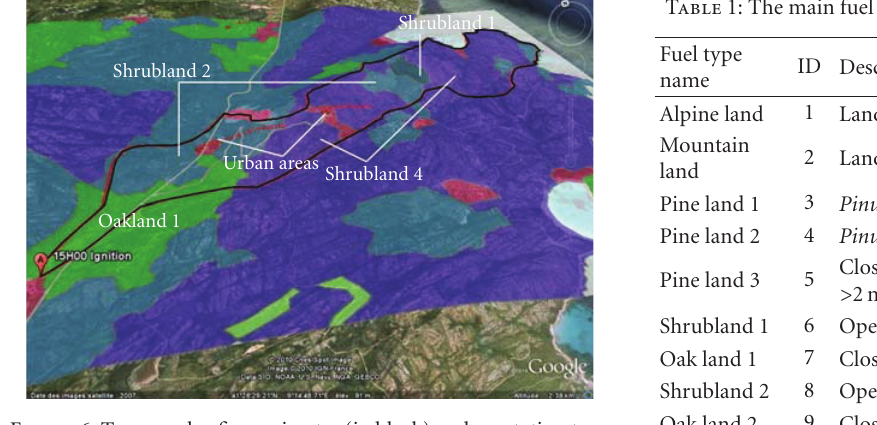
Figure 6: Topography, fire perimeter (in black) and vegetation type as defined in Table 1 for the case study of Suartone fire.